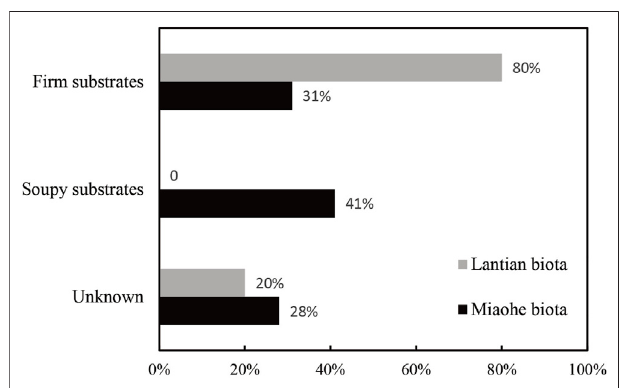
FIGURE 6 | The percentage of benthic macroalgae species more adapted torelatively fi rm and soupysubstrates in theLantian(10 species)and Miaohe biotas (29 species). Species not suitable for attachment strategy analyses classi fi ed as